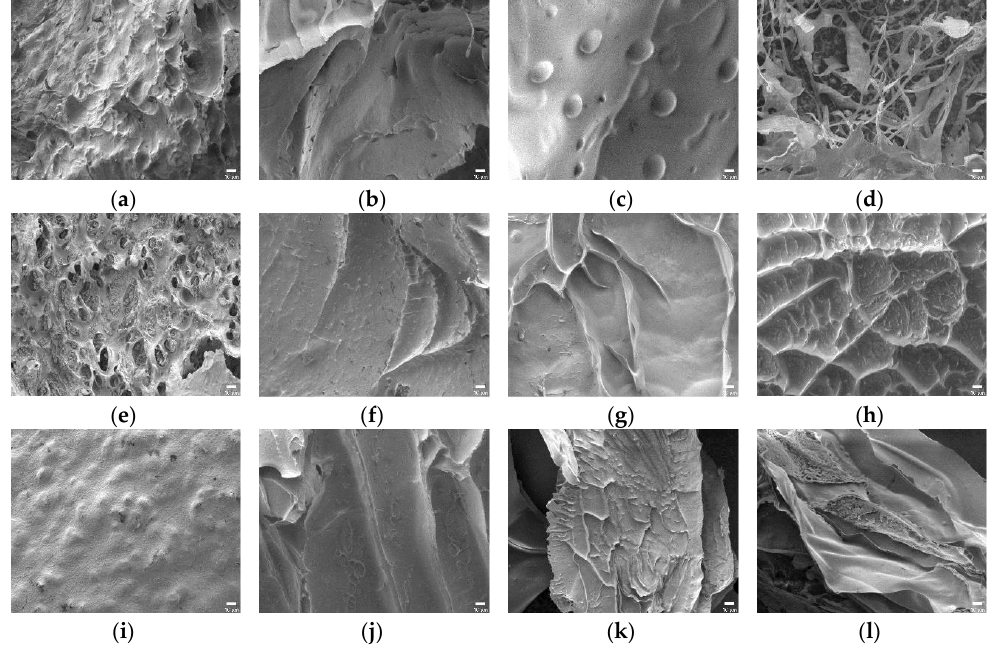
Figure 6. The FE-SEM images of polysaccharide-based SAPs ( × 1000, scale bar: 10 μm): ( a ) CS-CA0;